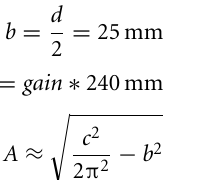
cursor path length (60, 120, or 180 mm) were 1:0.83, 1:0.42, or 1:0.28, and the relation between hand amplitude and visual